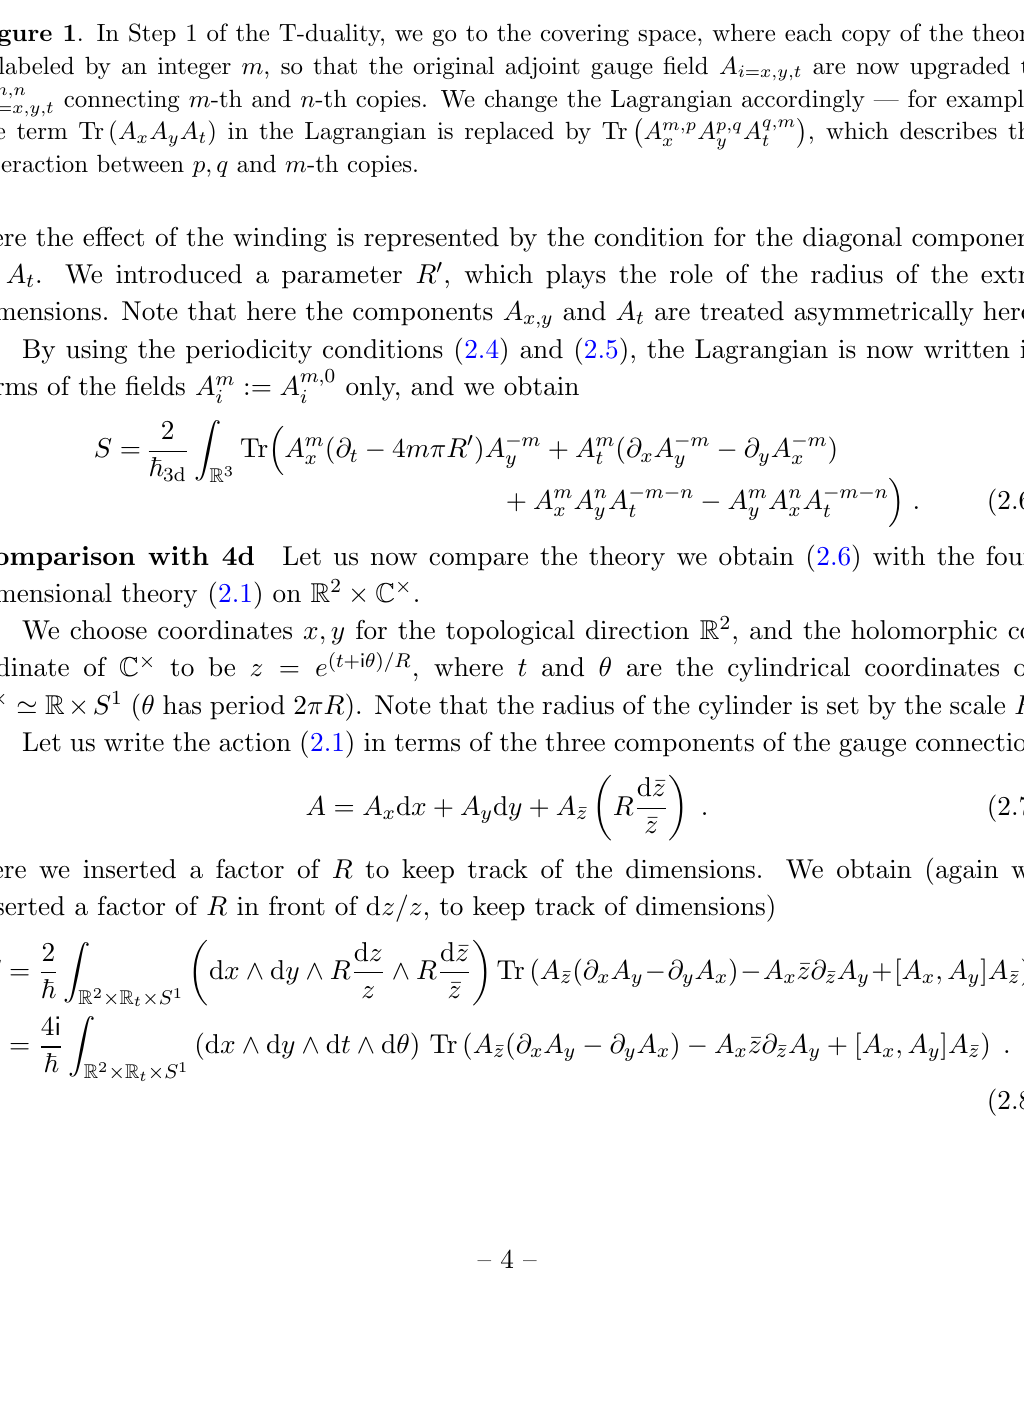
(cid:0) (cid:1) A m;p A p;q A q;m , which describes the t x y